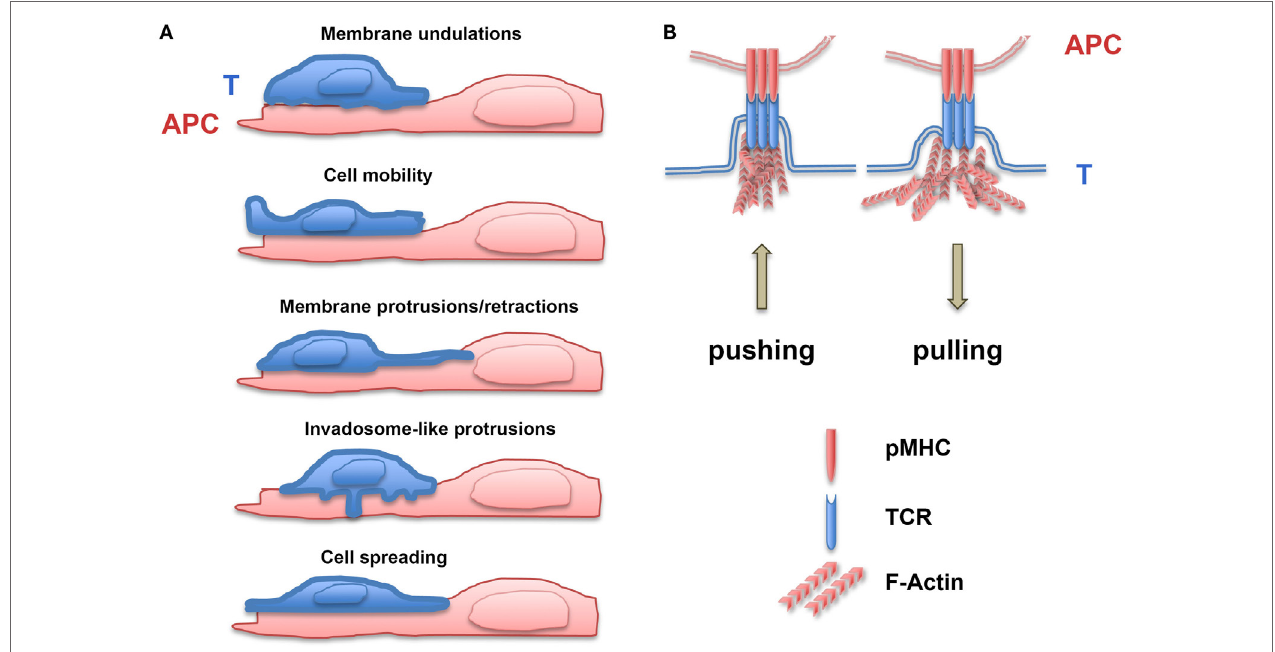
FiGURe 1 | Generation of forces during T lymphocyte/APC contacts . (A) Forces are exerted on receptor/ligand bonds by membrane T lymphocyte undulations, cell mobility, membrane protrusions/retractions, invadosome-like protrusions, and cell spreading on antigen-presenting cells (APC). (B) Upon TCR triggering, T lymphocytes develop pushing and pulling forces on TCR/pMHC bonds, which depend on polymerization of